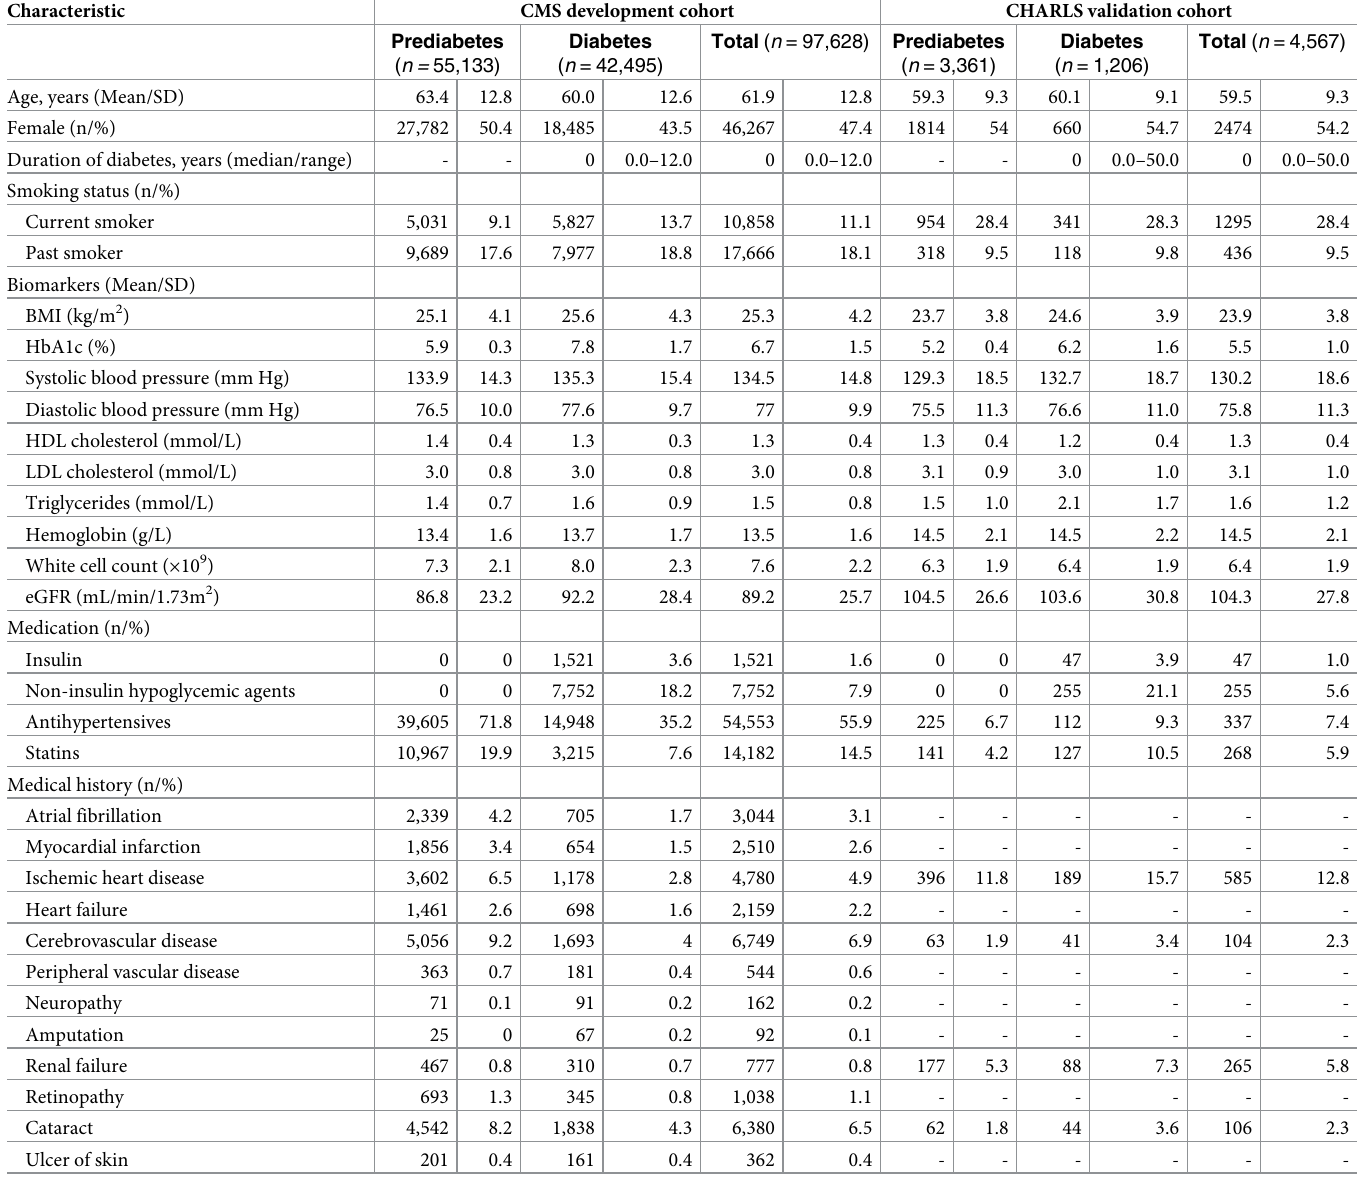
Table 1. Baseline characteristics of participants included in the